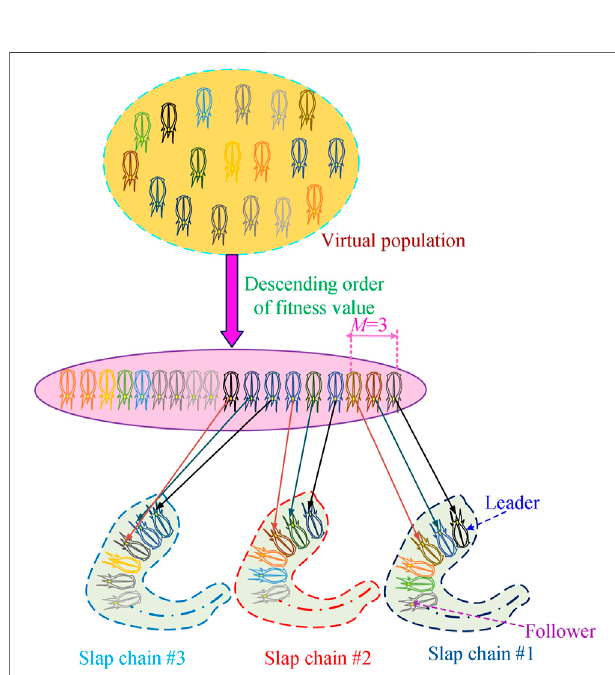
FIGURE 1 | Conceptual optimization framework of MSSA.